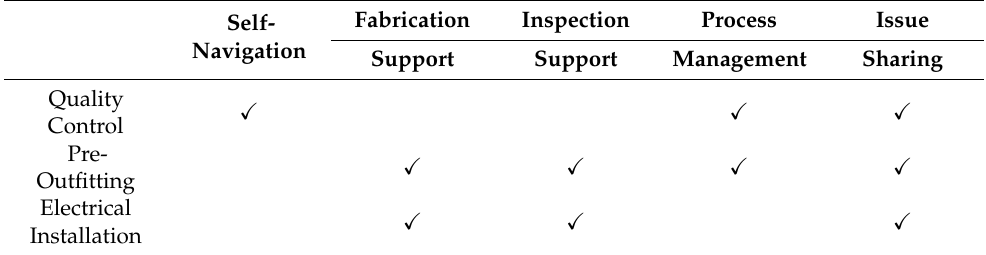
Table 2. List of supported AR services by work